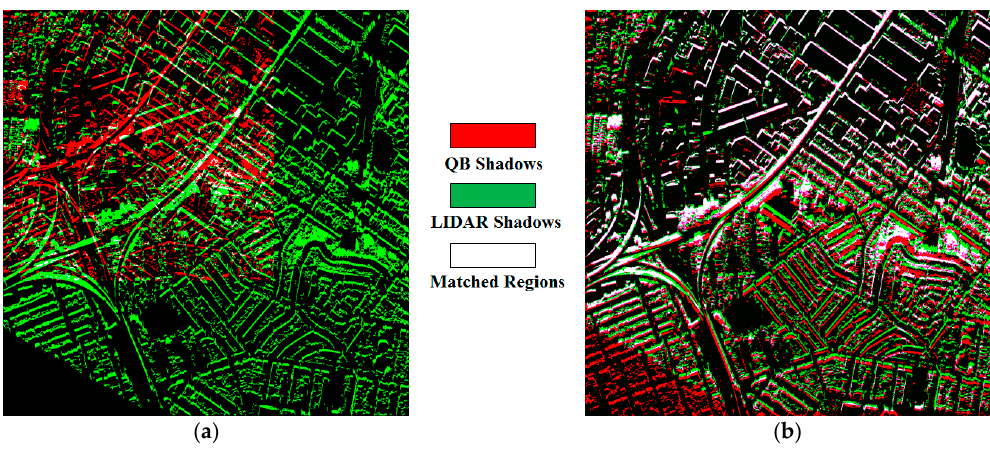
Figure 14. 2D-Similarity Transformation of the LSM to the ISM (Sample Dataset): ( a ) Before; ( b ) After.